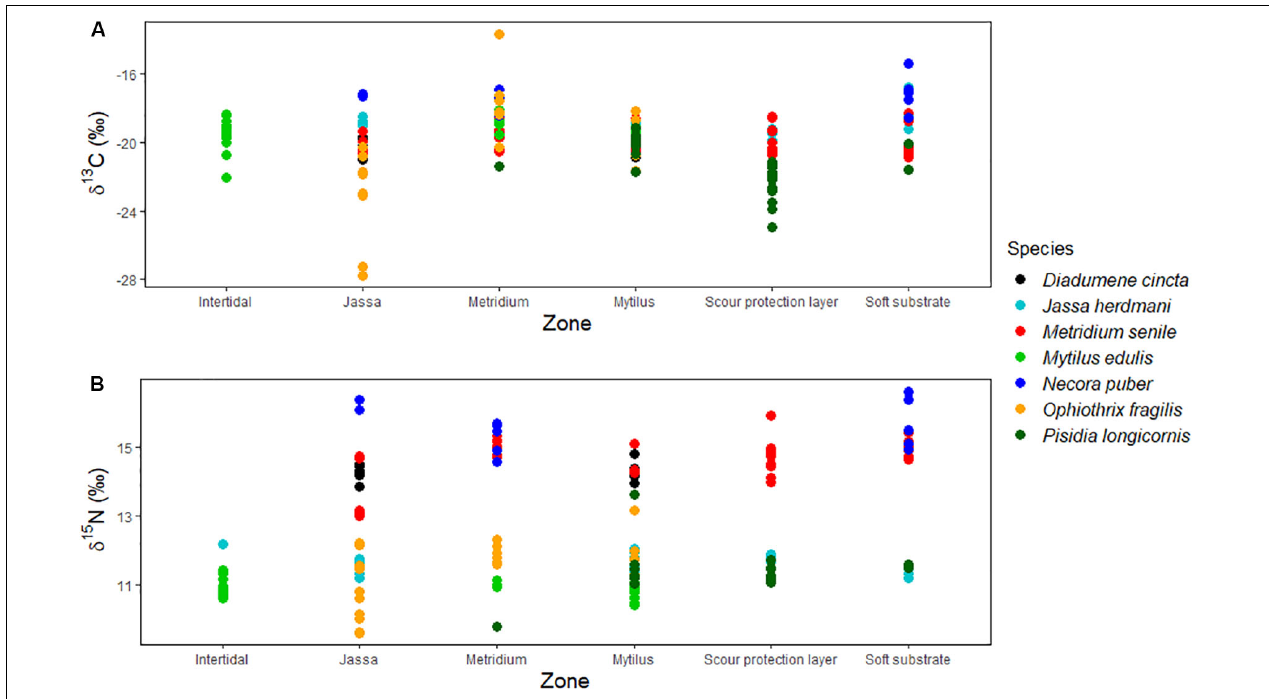
) of the consumers collected in the different depth zones. The different colors (cid:104)